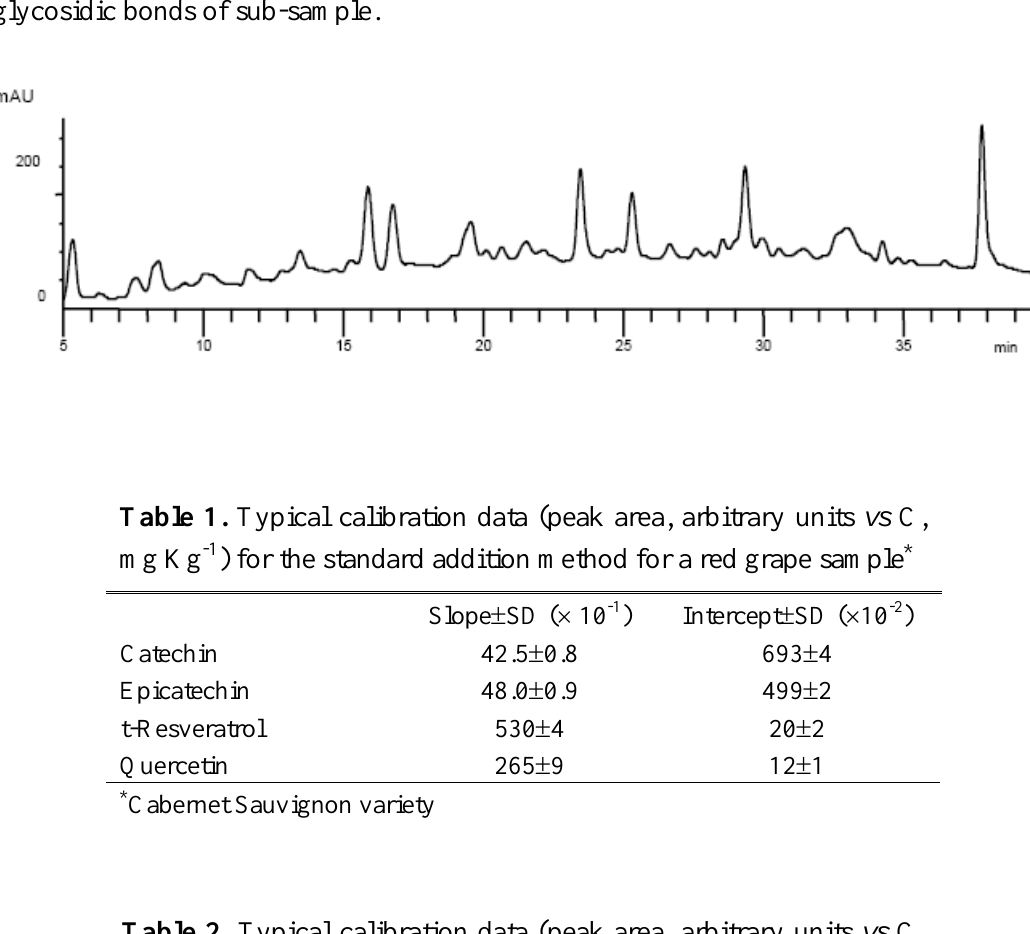
Table 2. Typical calibration data (peak area, arbitrary units vs